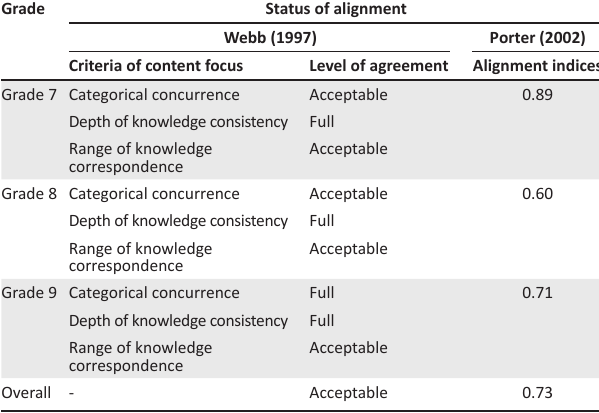
TABLE 6: Summary of the research